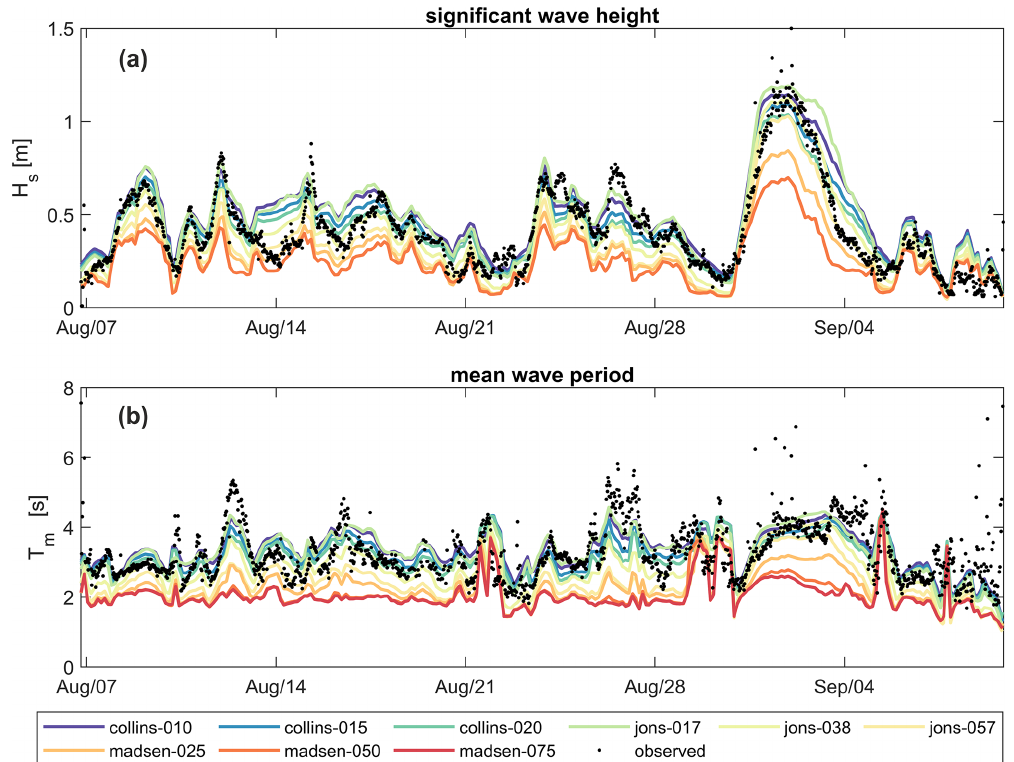
Figure 5. Wave height (a) and wave period (b) as observed (black dots) and modeled (colored lines) with the detailed domain using various friction formulations and coefficients for the observation period in 2019. Measurements were obtained with a Sofar Spotter anchored at 70.32 ◦ N, 147.76 ◦ W in approximately 3m water depth. Please note that the date format in this and following figures is month/day. Table 2. Skill scores for computed significant wave heights ( H s ) using various bottom friction formulations (BFFs) and coefficients. The Collins bottom friction formulation (Collins-BFF; Collins, 1972), with a coefficient of 0.020, was chosen for the remainder of this study (denoted in bold). Friction coefficients with an asterisk (*) are SWAN “default” values. The JONSWAP friction formulations are from Hasselmann et al. (1973), and the Madsen friction formulations are from Madsen et al. (1988). Friction Formulation Coefficient Legend name RMSE [m] MAE [m] Bias [m] SCI [%] Collins-BFF 0.010 collins-010